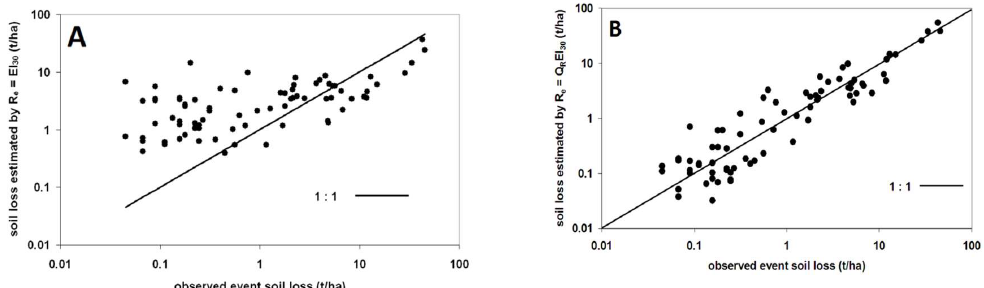
Figure 2. The relationship between observed event soil loss from plots 1–5 at Morris, Minnesota (MN) and soil losses predicted using ( A ) the EI 30 index (Equation (8)) and ( B ) replacing EI 30 by the product of the runoff ratio ( Q Re.1 ) and EI 30 (Equation (18)) (source Kinnell [31]). Obviously, the improvement is not as great when runoff is predicted rather than measured.